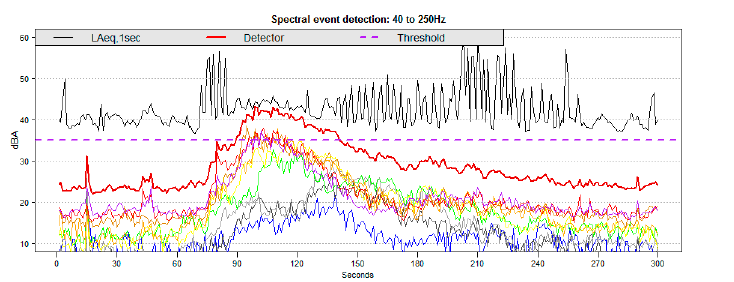
Figure 2. Spectrogram in third-octave bands of a low-exposure aircraft event (in dBA). The aircraft event is the blob between 90 and 150 s ( top ). The same event as a time series with L Aeq,1sec (black), the detector (red) and the detection threshold (purple dotted line) ( bottom ).